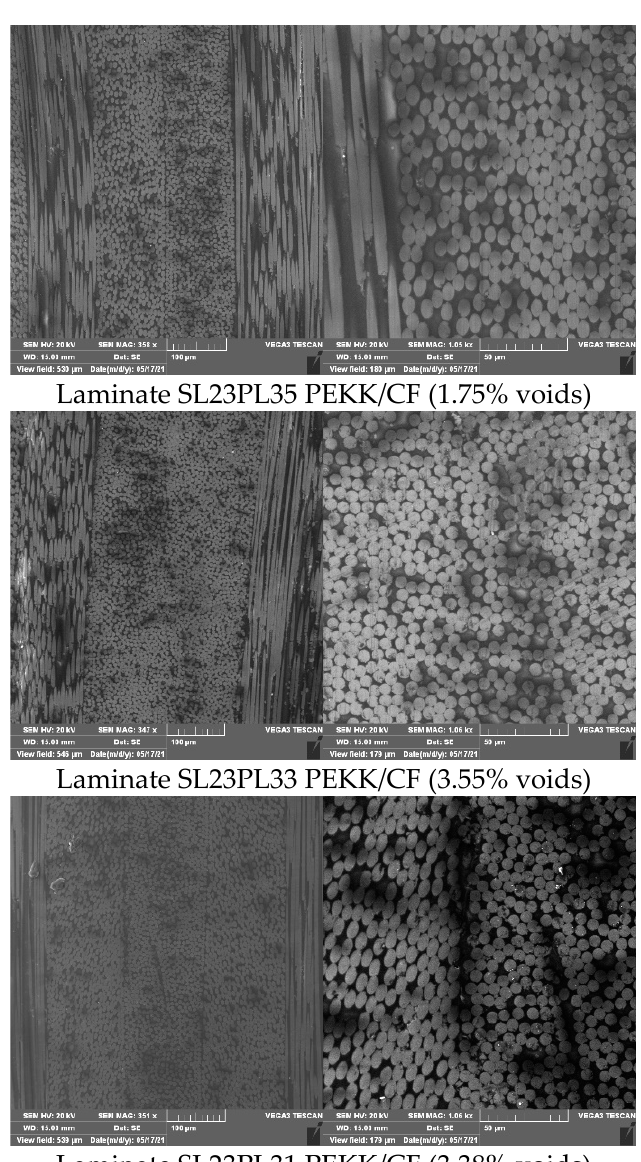
Figure 9. SEM images of the samples with PEKK resin. The samples marked SL23PL40 and SL23PL41 are obtained with a low speed of 3 m/min and with different compaction forces 200 and 1000 N. The sample SL23PL40, obtained with a lower compaction force, has a higher percentage of pores, and the pores are observed in the connection of the first layers. The SEM images with larger magnification clearly show that the fibers are well coated with a matrix and that it has achieved good adhesion. In the sample SL23PL41 (Figure 10), obtained with higher compaction force, parts with extruded polymer matrix were noticed, and the pore content was 1.76%. Both samples have a good interface, and a good quality connection between the layers is achieved. The results showed that the samples with a lower percentage of voids have higher mechanical characteristics